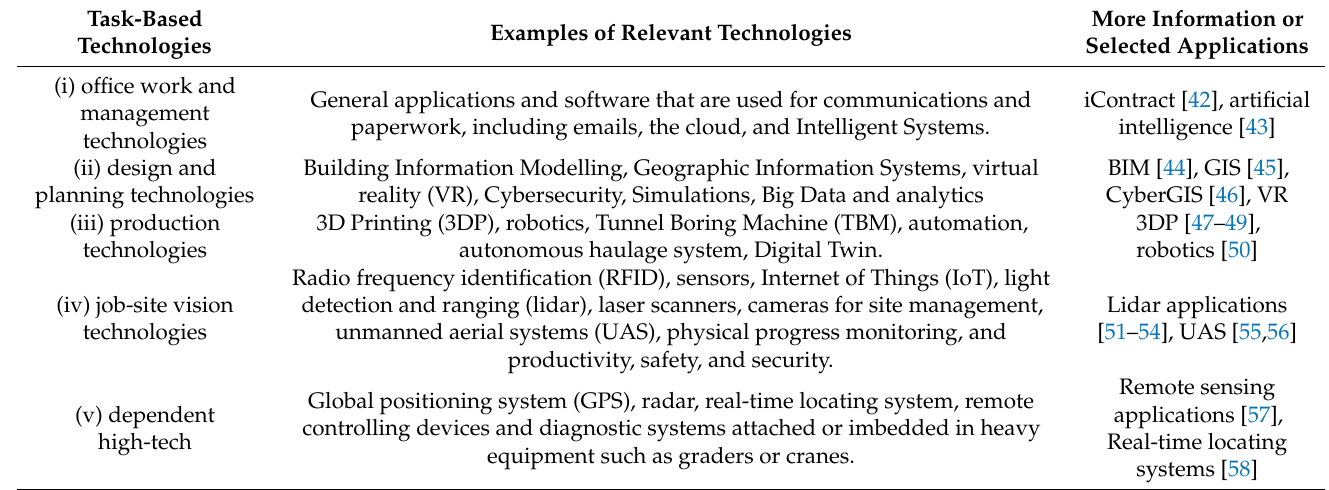
Table 1. Technology types based on different construction tasks, with